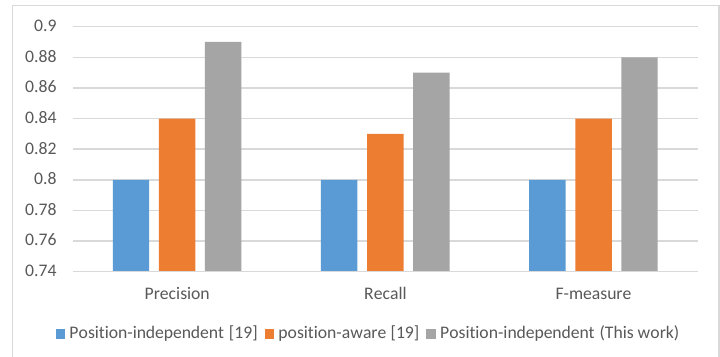
Figure 6. F-measure, precision, and recall of the proposed model compared to the position-independent and position-aware HAR in